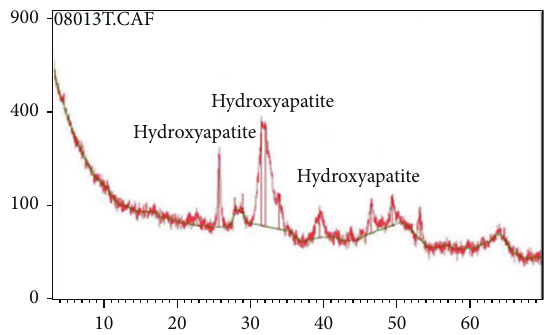
Figure 5: Outcome from the analysis through X-ray diffraction indicating hydroxyapatite as mineral structure of the massive